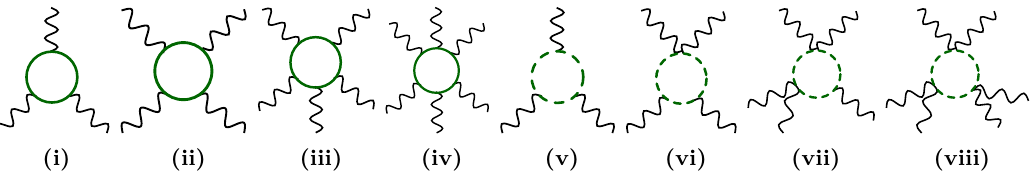
Figure 9 . One-loop diagrams built of Lorentz invariant renormalizable interactions of the UV theory that lead to effective operators of X 3 class.